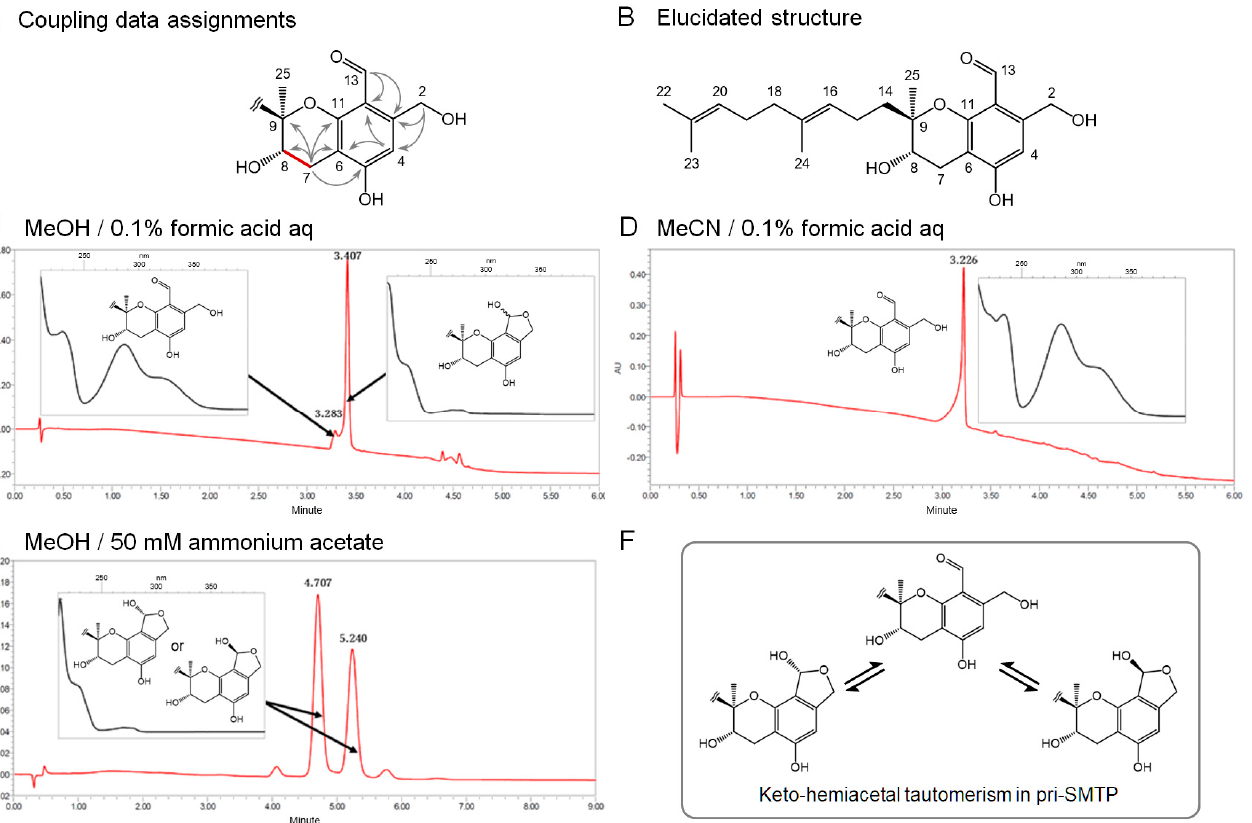
Figure 3. The elucidation of the structure of pri-SMTP and its keto-hemiacetal tautomerism. ( A ) Correlations observed in the 1 H − 1 H COSY (red bond) and HMBC spectra (arrows). ( B ) The elucidated structure of the aldehyde form of pri-SMTP. ( C ) The hemiacetal form of pri-SMTP predominates over the aldehyde form in the solvent system of MeOH/0.1% formic acid. ( D ) Pri-SMTP solely exists as the aldehyde form in the solvent system of MeCN/0.1% formic acid. ( E ) The epimers of the hemiacetal form of pri-SMTP can be separable in the solvent system of MeOH/50 mM ammonium acetate. ( F ) The summary of the observed tautomerism in pri-SMTP.